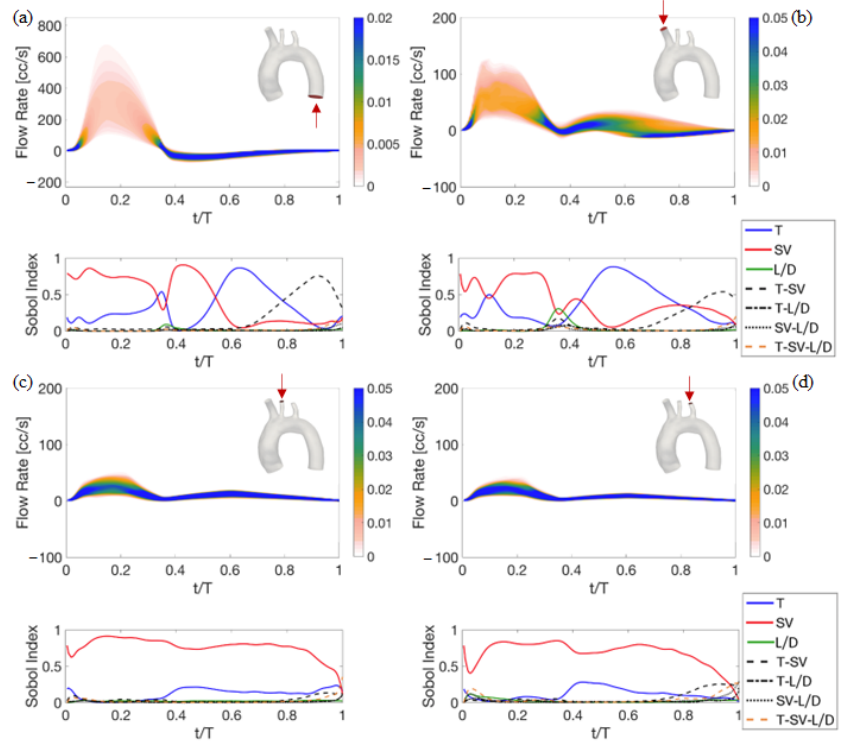
Figure 13. PDF of the waveforms of the flow rate (top panel) and relative Sobol indexes (bottom panel) at the four outlets of the healthy aorta: ( a ) DA, ( b ) BCA, ( c ) LCCA, and ( d ) LSA.